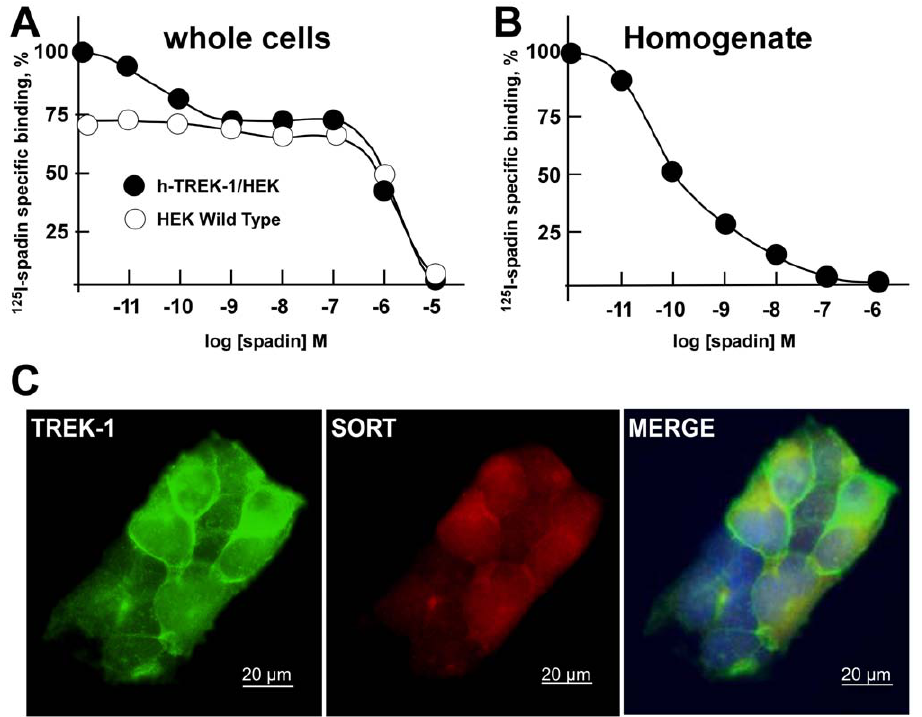
Figure 5. 125 I-spadin competition and immunolabeling experiments on h-TREK-1/HEK cells and HEK cells. A, B) 125 I-spadin competition experiments performed on whole cells (n=3) and on plasma membrane homogenate (n=3). c) Immunolabelling of h-TREK-1 (green labeling) and sortilin (red labeling) proteins. The co-localization of the two proteins is shown on the Merge picture.